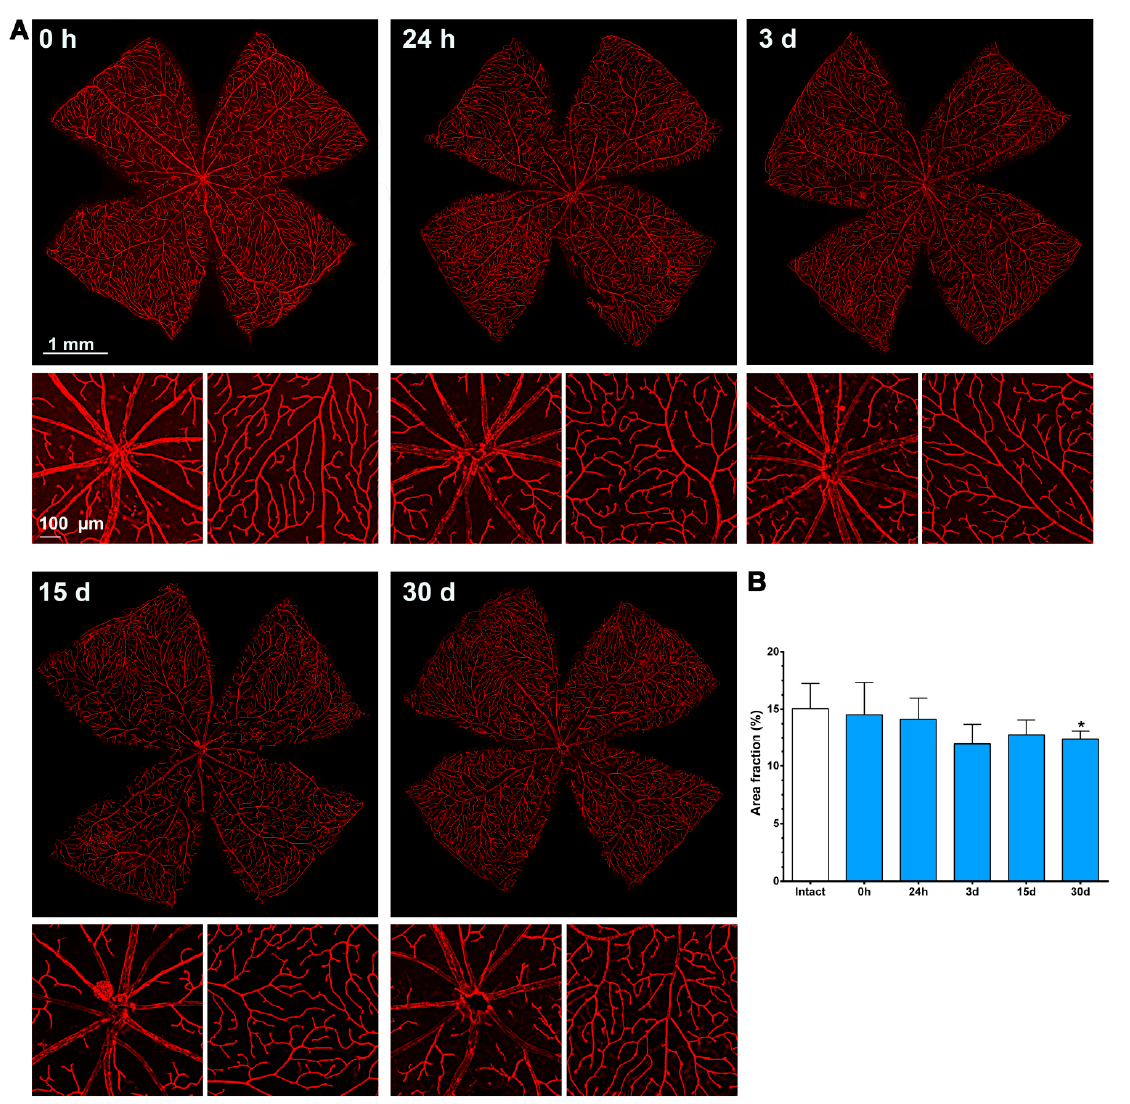
Figure 7. Changes in the retinal vasculature of the contralateral uninjured retinas. ( A ) Ly6c immunodetection showing the superficial plexus (P1) of contralateral retinas analyzed from 0 h (immediately after) to 30 days after the induction of the ischemia. Below each photomontage are shown magnifications of the optic nerve head or retinal periphery. ( B ) Bar graphs showing the area fraction of the retina covered by P1 ± standard deviation in intact and contralateral retinas. * Significant compared to intact retinas ( p < 0.05, Kruskal–Wallis, Dunn’s multiple comparisons test). 1 mm and 100 µm scale bars are for photomontages and magnifications, respectively.